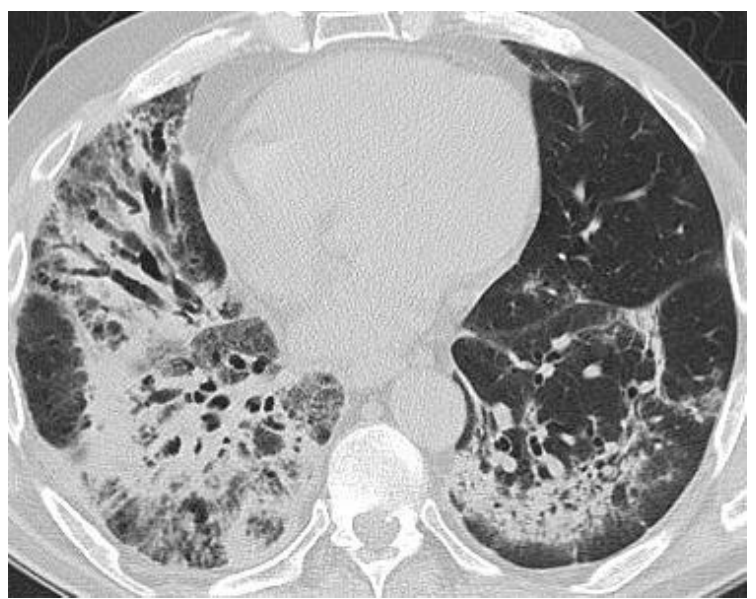
Figure 3. Chest computed tomography scan after 16 weeks of immunological treatment: ground-glass opacities in both lungs, more prominent in right lung.